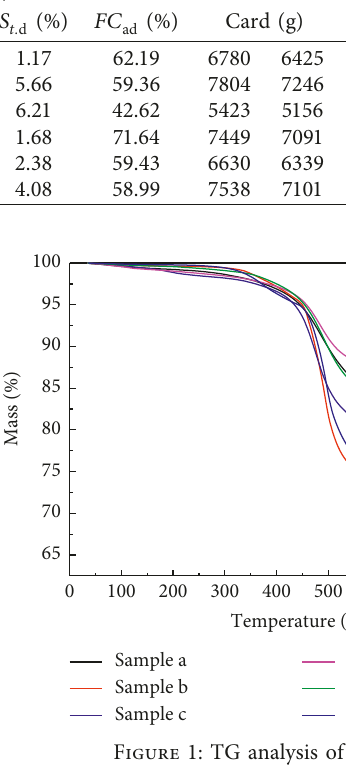
Figure 1: TG analysis of coal samples.